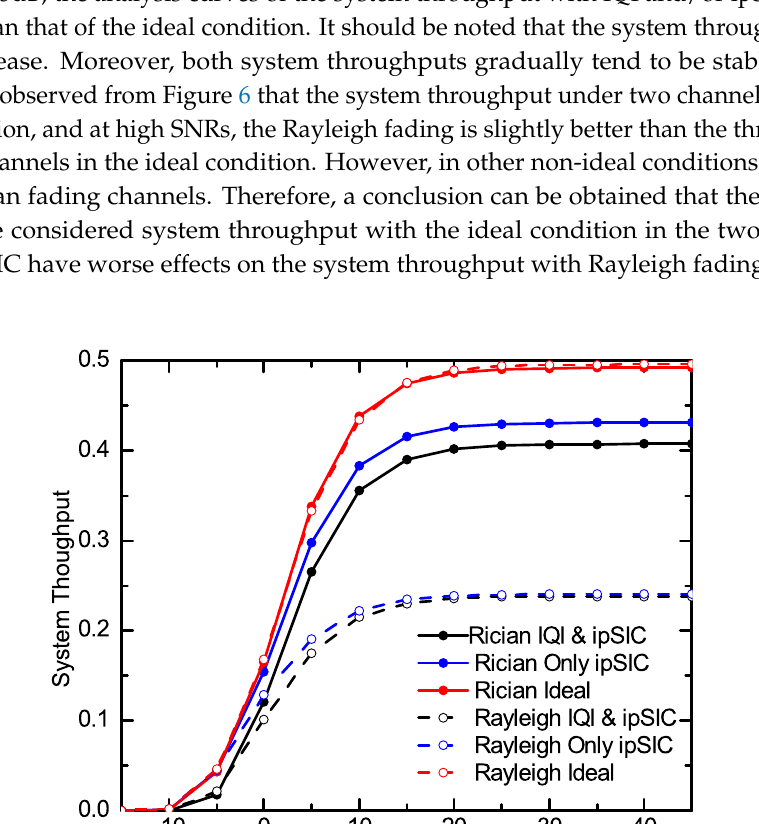
Figure 6. System throughput versus the transmit SNR of the proposed TWR C-NOMA system for D 1 and D 2 with data rate thresholds ¯ R 1 = 0.2 BPCU and ¯ R 2 = 0.3 BPCU .